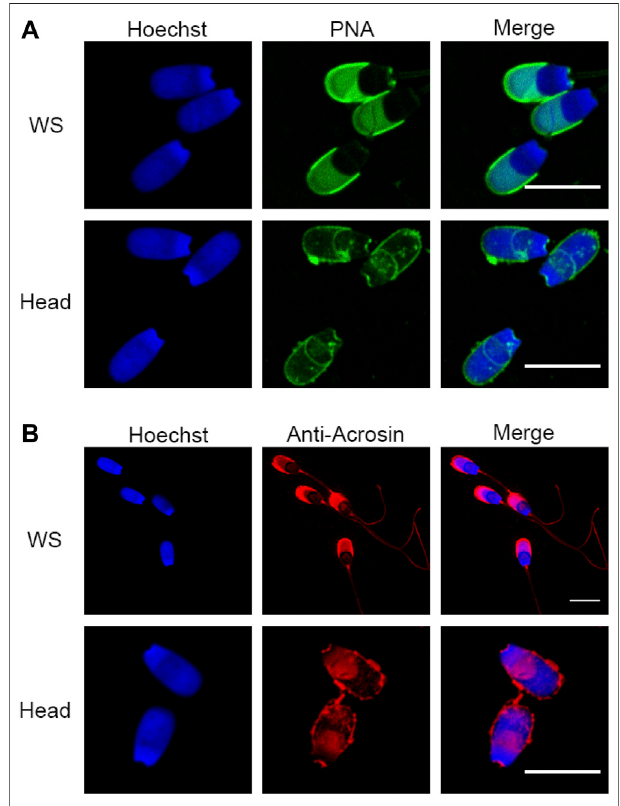
FIGURE 2 | Assessment of sperm head and tail separation using immuno fl uorescence. (A) Immuno fl uorescencestainingwithpeanutagglutinin lectin (PNA) in whole sperm cells (WS) and fractionated sperm heads. (B) Immuno fl uorescence of acrosin in WS and fractionated sperm heads. Scale bar = 10 μ